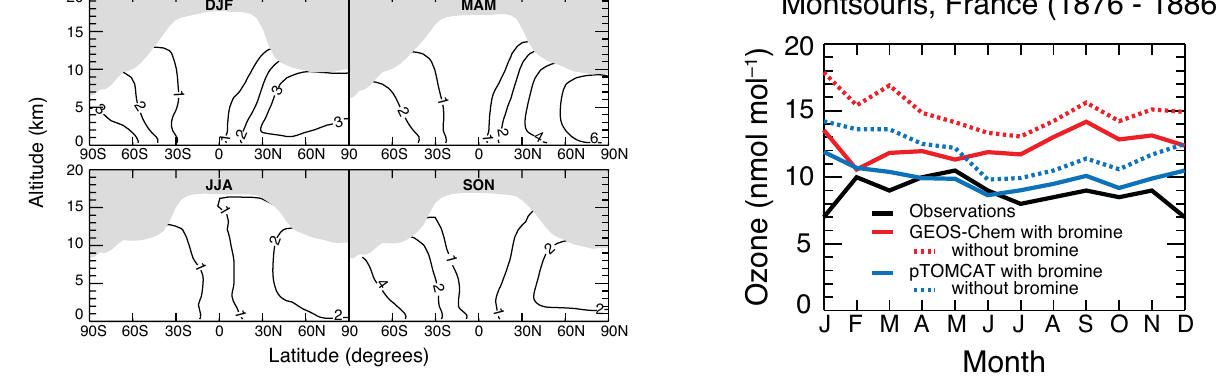
Fig. 7. Mean seasonal variation of 19th-century ozone in surface air at Montsouris, France (50 ◦ N, 2 ◦ E). 1876–1886 observations re- analyzed by Volz and Kley (1988) (black) are compared to preindus- trial model simulations using GEOS-Chem (red) and p-TOMCAT (blue), with bromine chemistry (solid) and without